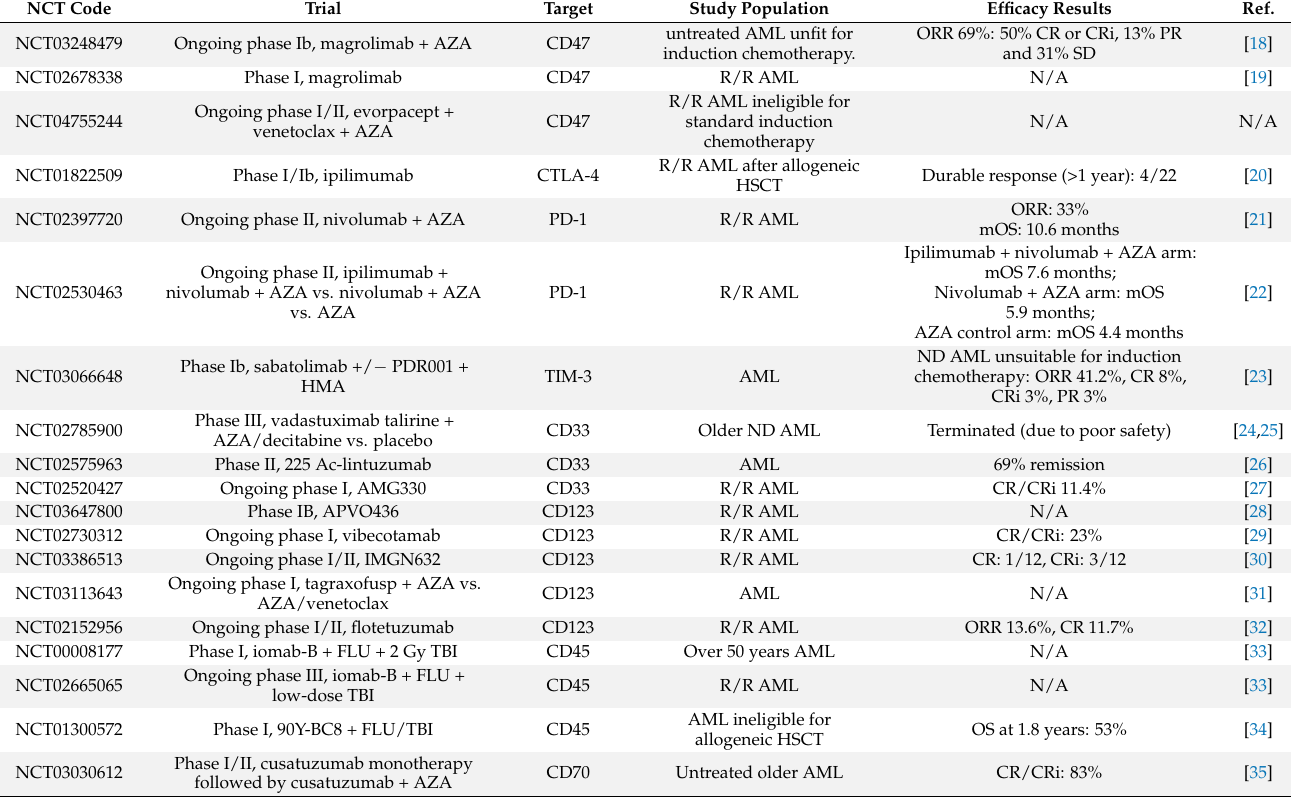
Table 1. Clinical trials with innovative mAbs in AML.